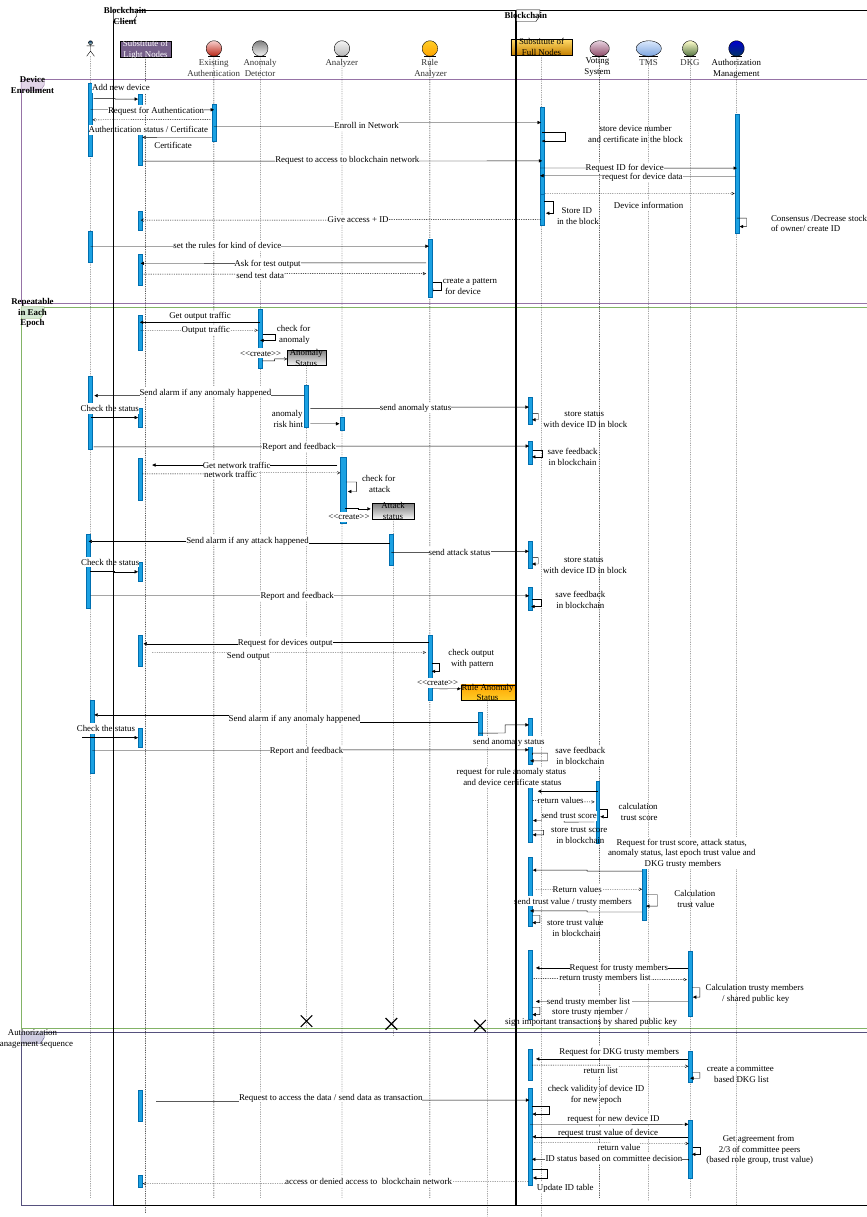
Figure A1. Sequence diagram of